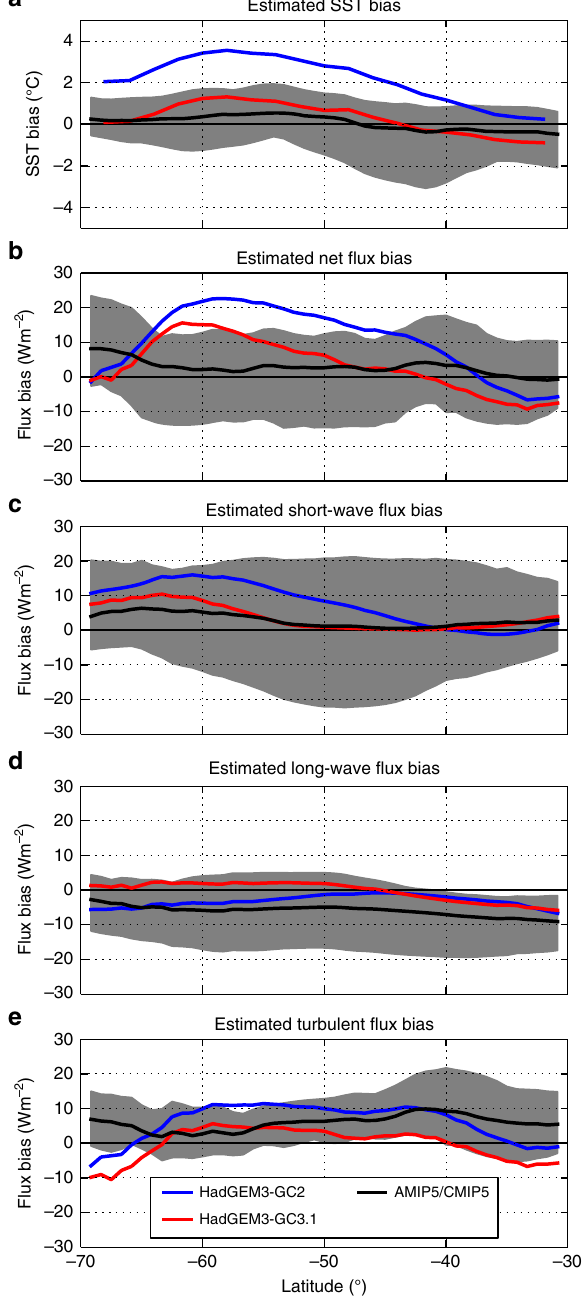
Fig. 6 Simulated ocean-area zonal mean coupled SST biases and stand- alone atmospheric model heat fl ux component biases for HadGEM3-GC3.1 and HadGEM3-GC2. ( a ) SST biases, ( b ) net downwards surface heat fl ux biases, ( c ) net downwards surface short-wave radiation fl ux biases, ( d ) net downwards long-wave radiation fl ux biases and e total downwards turbulent heat fl ux biases for HadGEM3-GC2(-A) (blue) and HadGEM3- GC3.1(-A) (red). The AMIP5/CMIP5 multi-model mean (black line) and spread (grey shading) for the 18 consistent AMIP5/CMIP5 models (see Methods) are included on all panels. The HadGEM3-GC2 and HadGEM3- GC3.1 SST biases are for present day control runs for years 50 to 100. The maximum estimated zonal mean observational errors between 35 and 65°S for SST, net fl ux, short-wave fl ux, long-wave fl ux and turbulent fl ux are